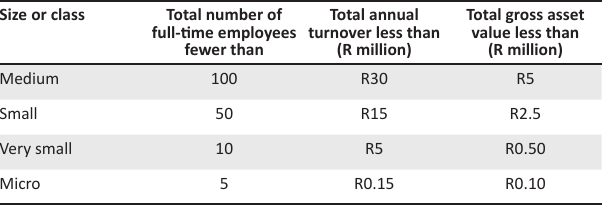
TABLE 1: Business classification according to the National Small Business Act (No. 102 of 1996). Size or